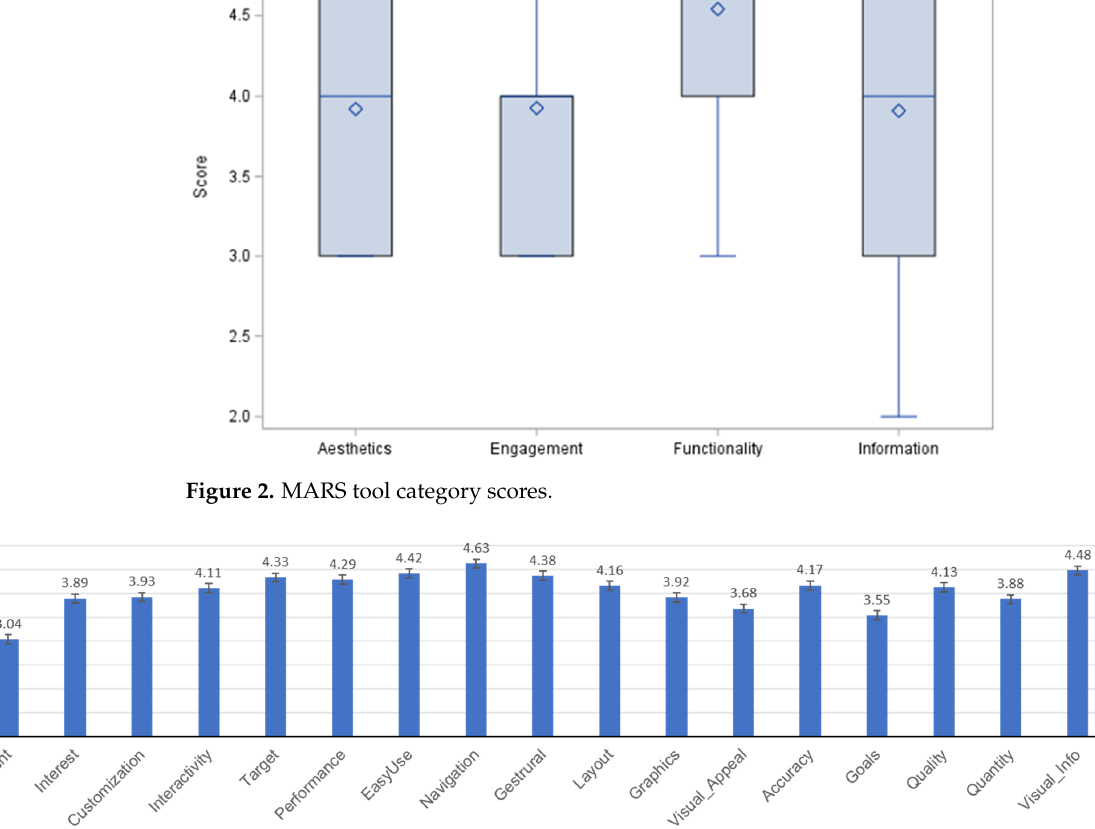
Figure 3. MARS Tool category distribution. (1) Engagement